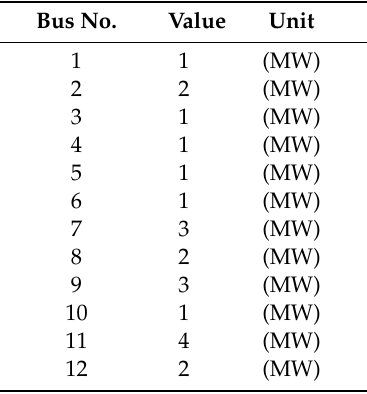
Table 1. Load Capacity of each bus.